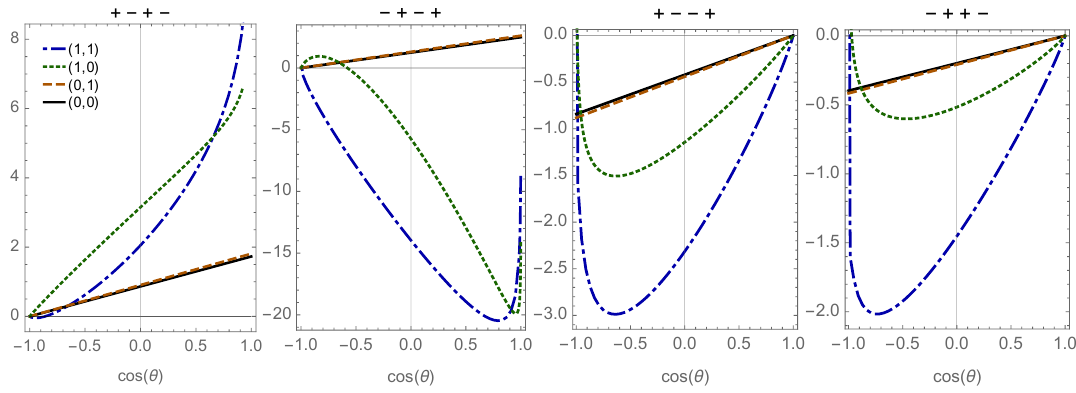
Figure 6 . Helicity amplitudes for u ¯ u → ‘ + ‘ − in dependence on the cosine of the scattering angle √ √ for s = 500 GeV and µ R = s . The figure shows the real parts of the polarized hard scattering functions (finite remainders) Re H ( m,n ) / (4 π ) m + n , see eqs. (6.5)–(6.8), where the relative orders λ 1 λ 2 λ 3 λ 4 in the electroweak and strong couplings are denoted by ( m, n )